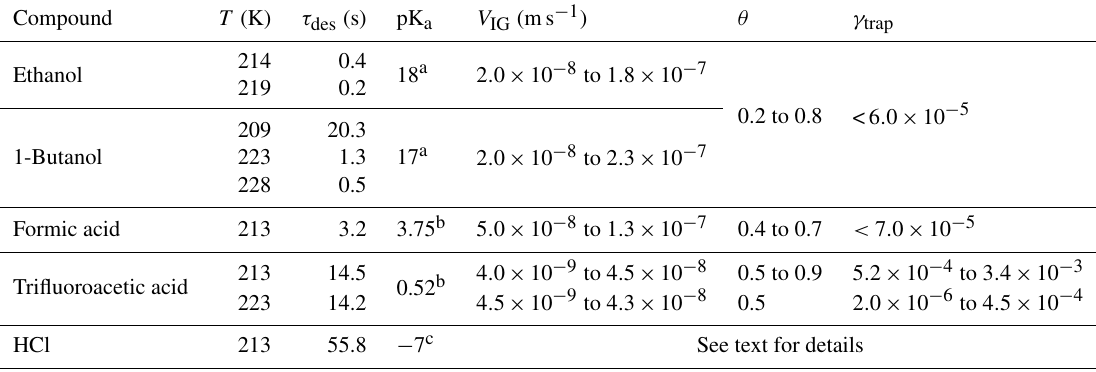
Table 1. Summary of results.